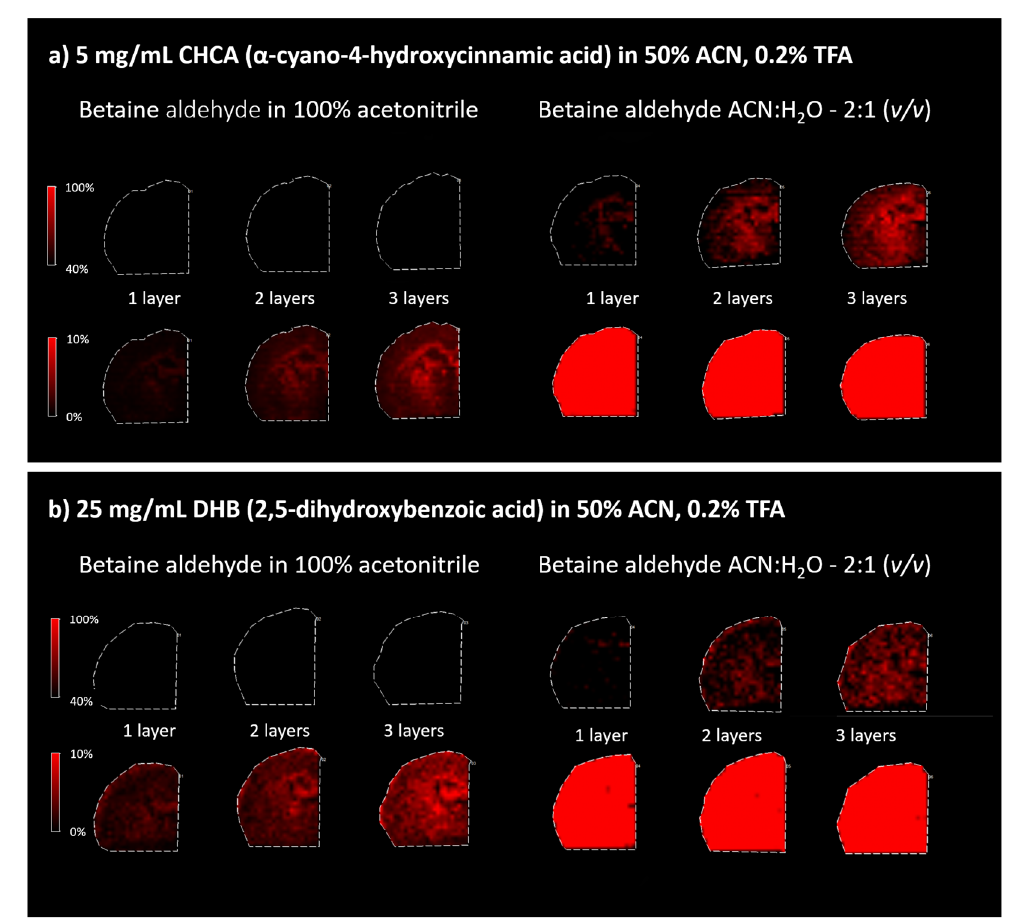
Figure 3. The results of the analysis for different matrices, betaine aldehyde solutions, and the number of layers. ( a ) CHCA and ( b ) DHB matrices. Left panels: saturated solution of betaine aldehyde in 100% acetonitrile. Right panels: solution of 0.1% betaine aldehyde in ACN:H 2 O (2:1, v / v ). The rows for each matrix present the heatmap for the same analysis with the changes in the % of displayed intensity. The top rows in ( a , b ) represent the intensity scale from 40 to 100%, where 100% is for the most intensive cholesterol signal. The bottom rows represent the scale adjustment of the intensity from 0 to 10%, which allows for the observation of signals of lower intensity, which are invisible when the 40–100% range is used.